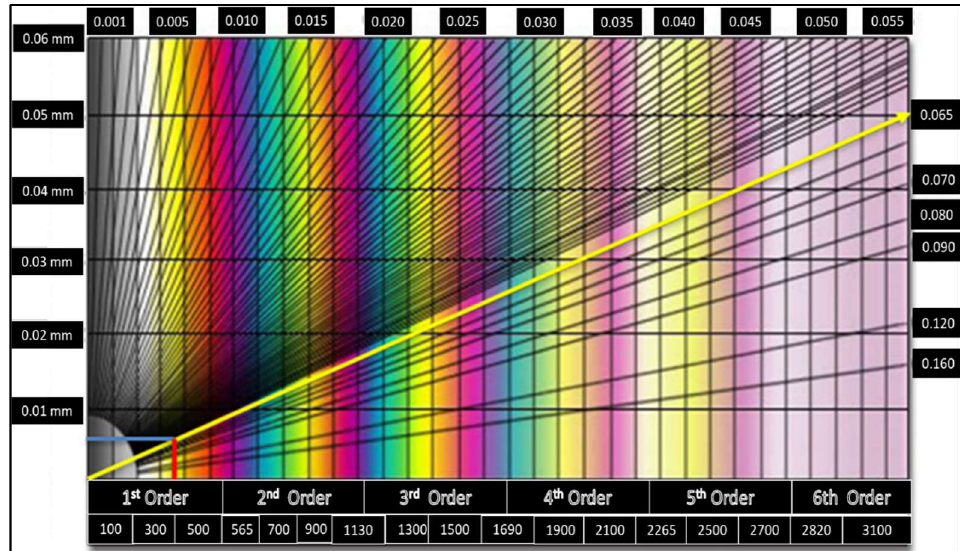
Fig. 4. Michel- Levy birefringence colour chart, demonstrating the retardation value of MDN crystal thickness according to the SEM measurements. By intersecting the diagonal line starting from 0.065 (yellow line) with blue line at 6.62 µm (the mean value of MDN crystals thickness) and drawing the red line perpendicular on the x-axis, the